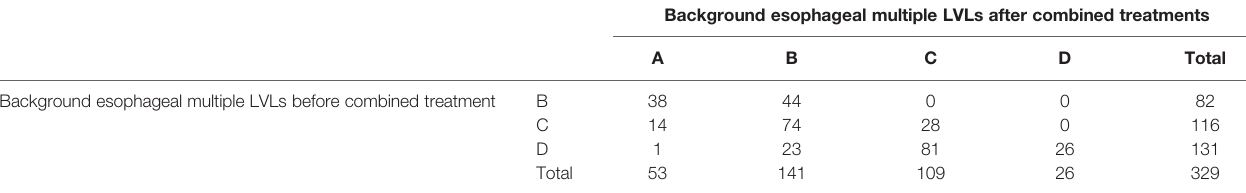
TABLE 4 | Comparison of background esophageal multiple LVLs before and after combined treatment.